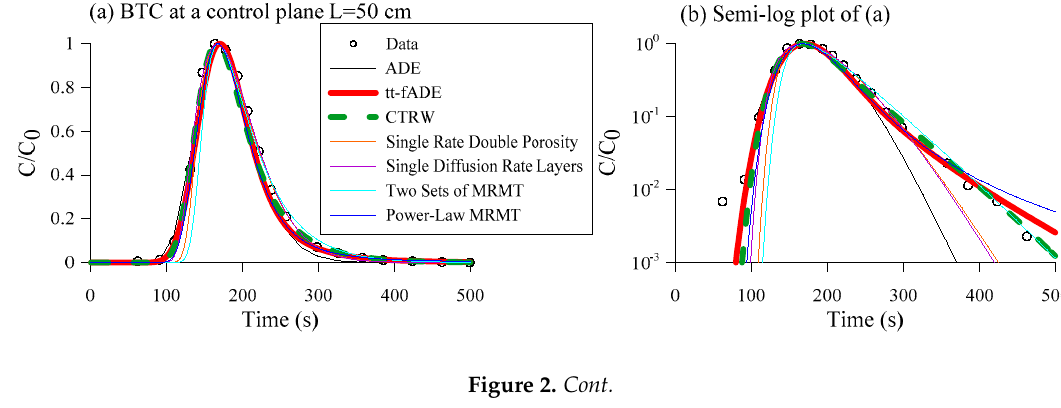
Figure 2. Laboratory tracer test: Comparison between the measured (symbols) and the modeled (lines) breakthrough curves (BTCs) using the advection–dispersion equation (ADE), the tempered time fractional advection–dispersion equation (tt-fADE) (red thick lines), the continuous time random walk (CTRW) (green dashed lines), and the multi-rate mass transfer (MRMT) model with the water flow rate Q = 1.4 mL/s. 4. Model Fit and Comparison Comparisons of the measured and best-fit BTCs using the above three time-nonlocal transport models and the classical ADE are shown in Figure 2 and Figures S6–S10 in the Supplementary File. In this section, we briefly introduce the model fitting process, and then compare the model results. 4.1. The ADE Model with Equilibrium Sorption For comparison, we first use the classic ADE with equilibrium sorption to quantify the measured BTCs. The governing equation for one-dimensional chemical transport in groundwater with advection, dispersion, and retardation is